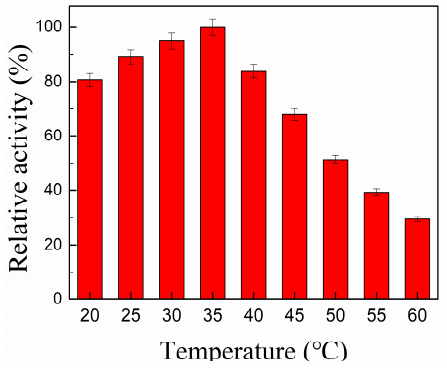
Figure 3. The thermal stability of CALB@PE.